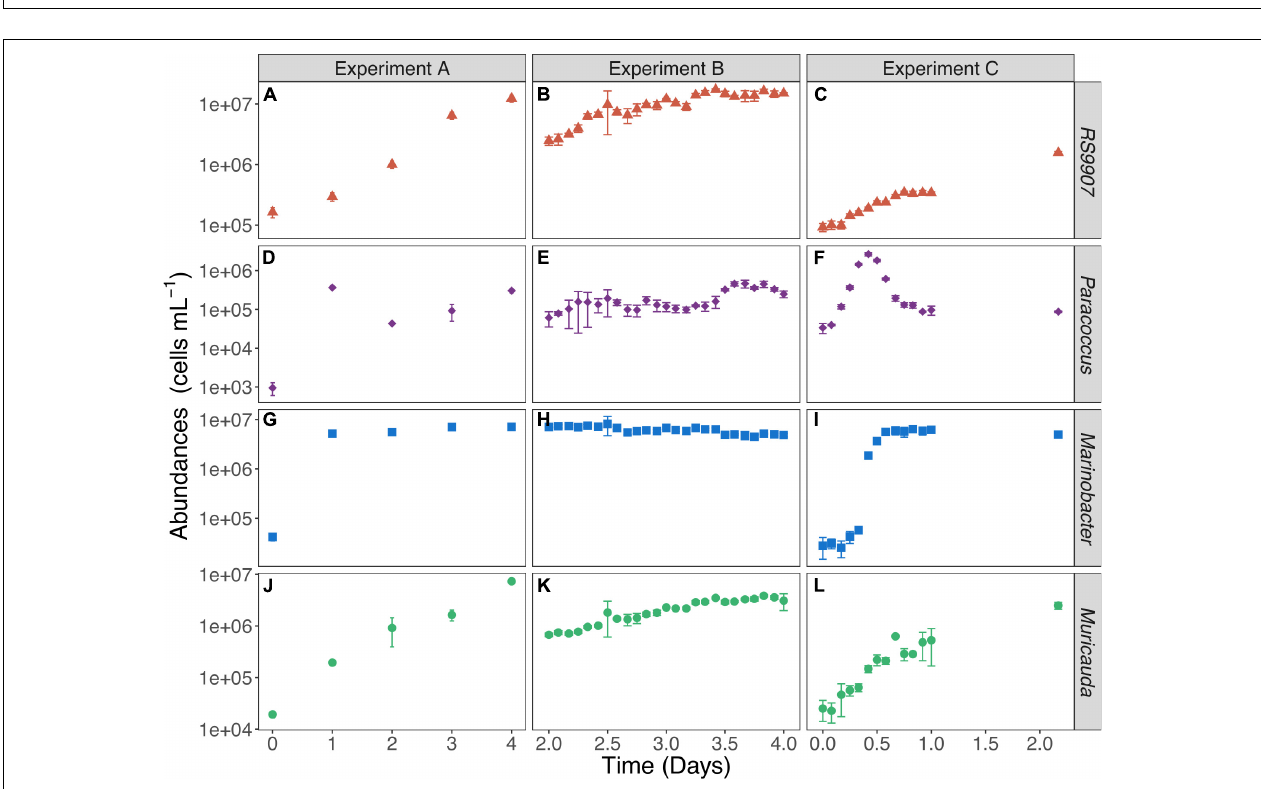
FIGURE 3 | (A) Absolute abundance of heterotrophic bacteria (i.e., sum of all heterotrophic cells counted by flow cytometry) and (B) proportion of heterotrophic bacteria to total bacterial cells vs. the abundance of RS9907 at 28 ◦ C in the three experiments. Each symbol corresponds to one daily measurement. Error bars represent the standard deviations of 4 replicates in experiment A and triplicates in experiments B and C.